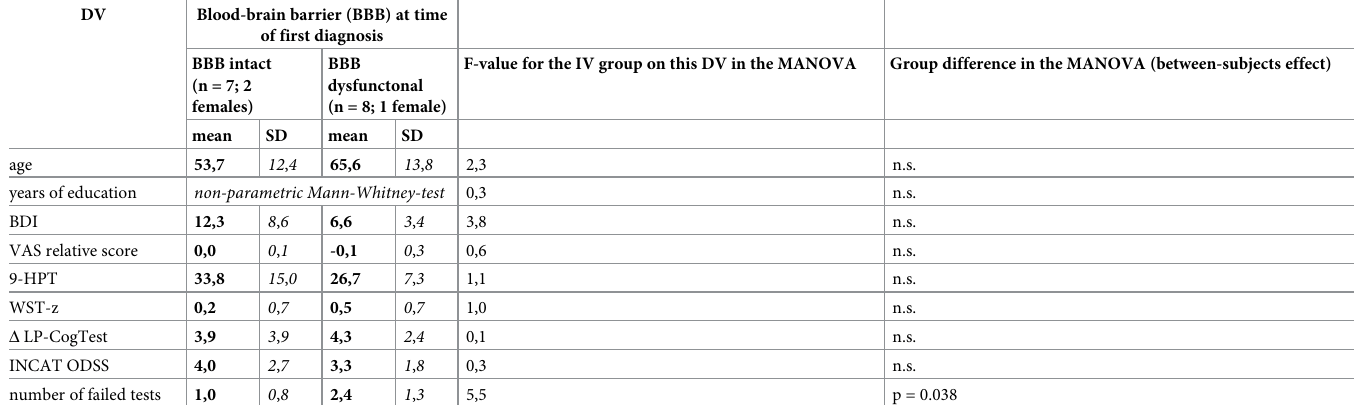
Table 4. Neuropsychological performance of CADP patients with intact and dysfunctional blood-brain barrier. BDI = Beck Depression Inventory; 9-HPT = 9-hole- Peg-test; WST-z = Wortflu¨ssigkeitstest Z-score; Δ LP-CT = time between the lumbar puncture and cognitive testing in years; INCAT ODSS = INCAT Overall Disability Sum Score; BBB = blood-brain-barrier; IV = independent variable; DV = dependent variable; n.s. = not significant; ⁰ = mean rank; ⁰⁰ = non-parametric Mann-Whitney- test. n.s = not significant (p > 0.05). DV Blood-brain barrier (BBB) at time of first diagnosis